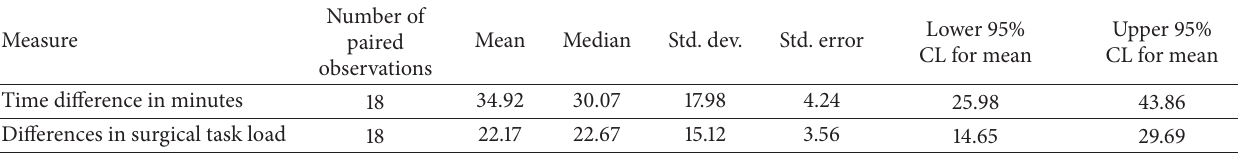
Table 4: Statistical analyses for differences between suture and mechanical fixation